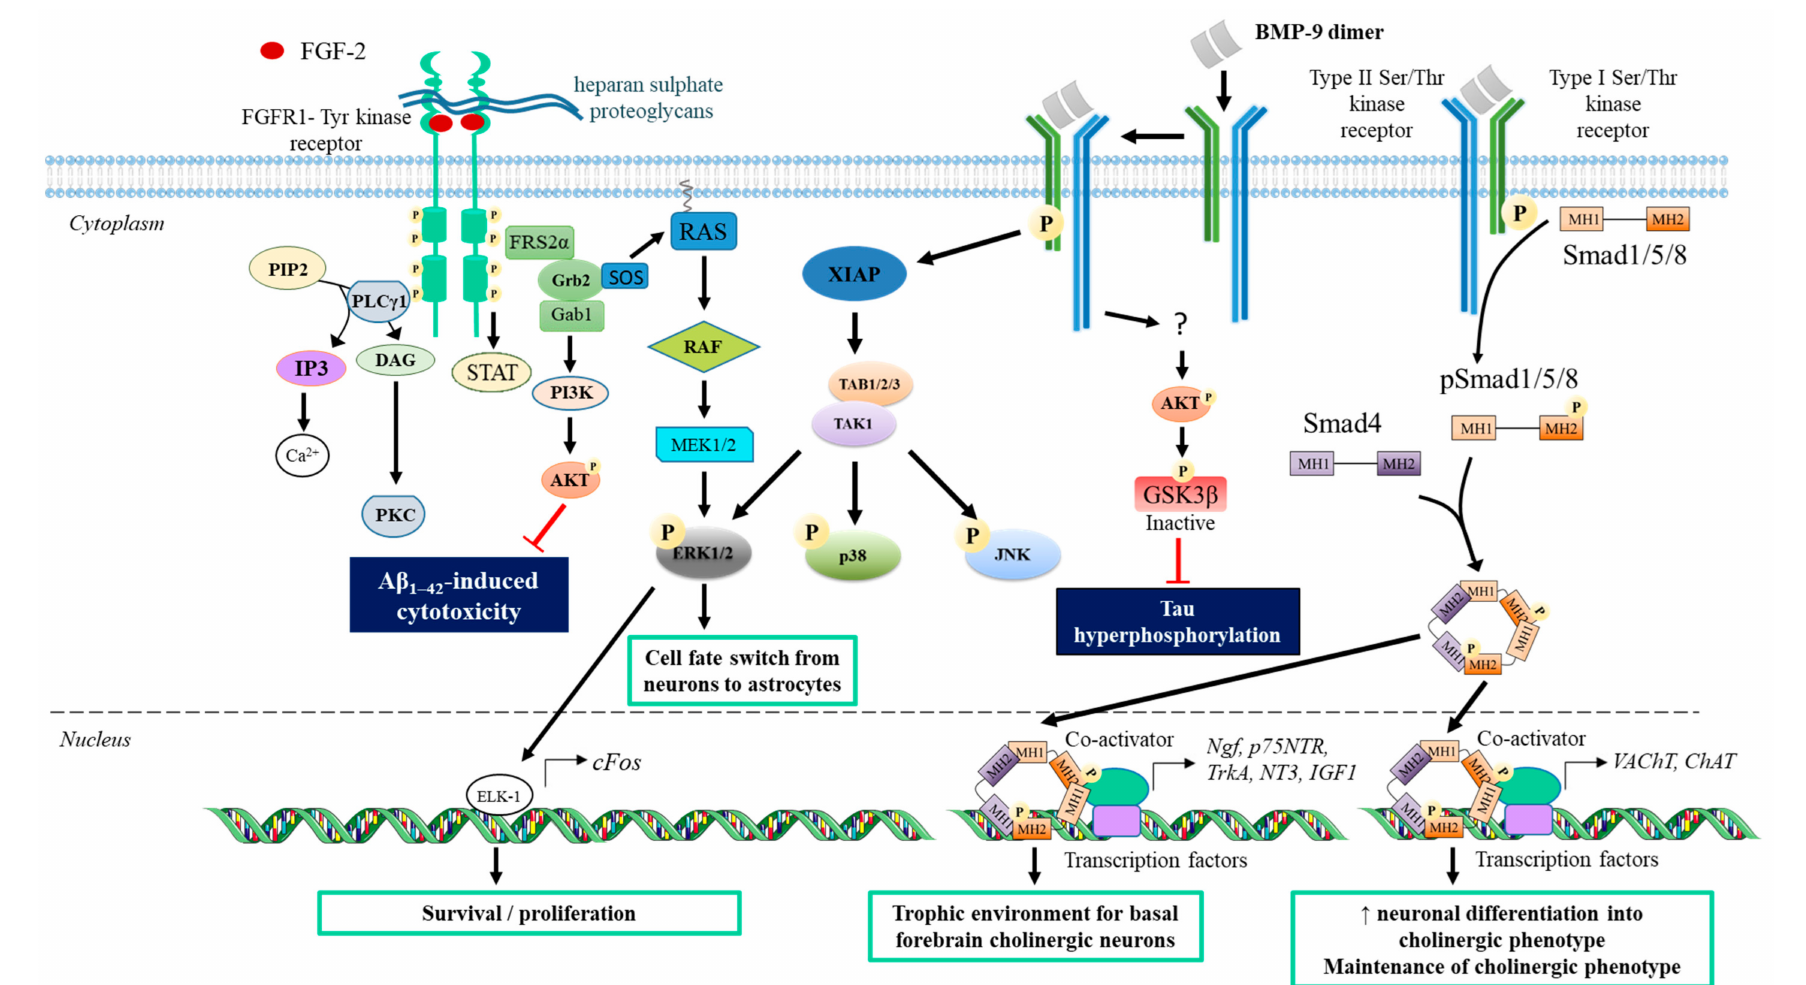
Figure 3. FGF-2 and BMP-9 signaling pathways and their roles in healthy and AD brains [106,185,188–192]. GAB1: Grb2-associated binder-1; SOS: salt overly sensitive; TAB1/2/3: TAK1 binding protein 1/2/3; TAK: transforming growth factor β -activated kinase 1; XIAP: X-linked inhibitor of apoptosis. The figure was created using Servier Medical Art (https://smart.servier.com; 30 April